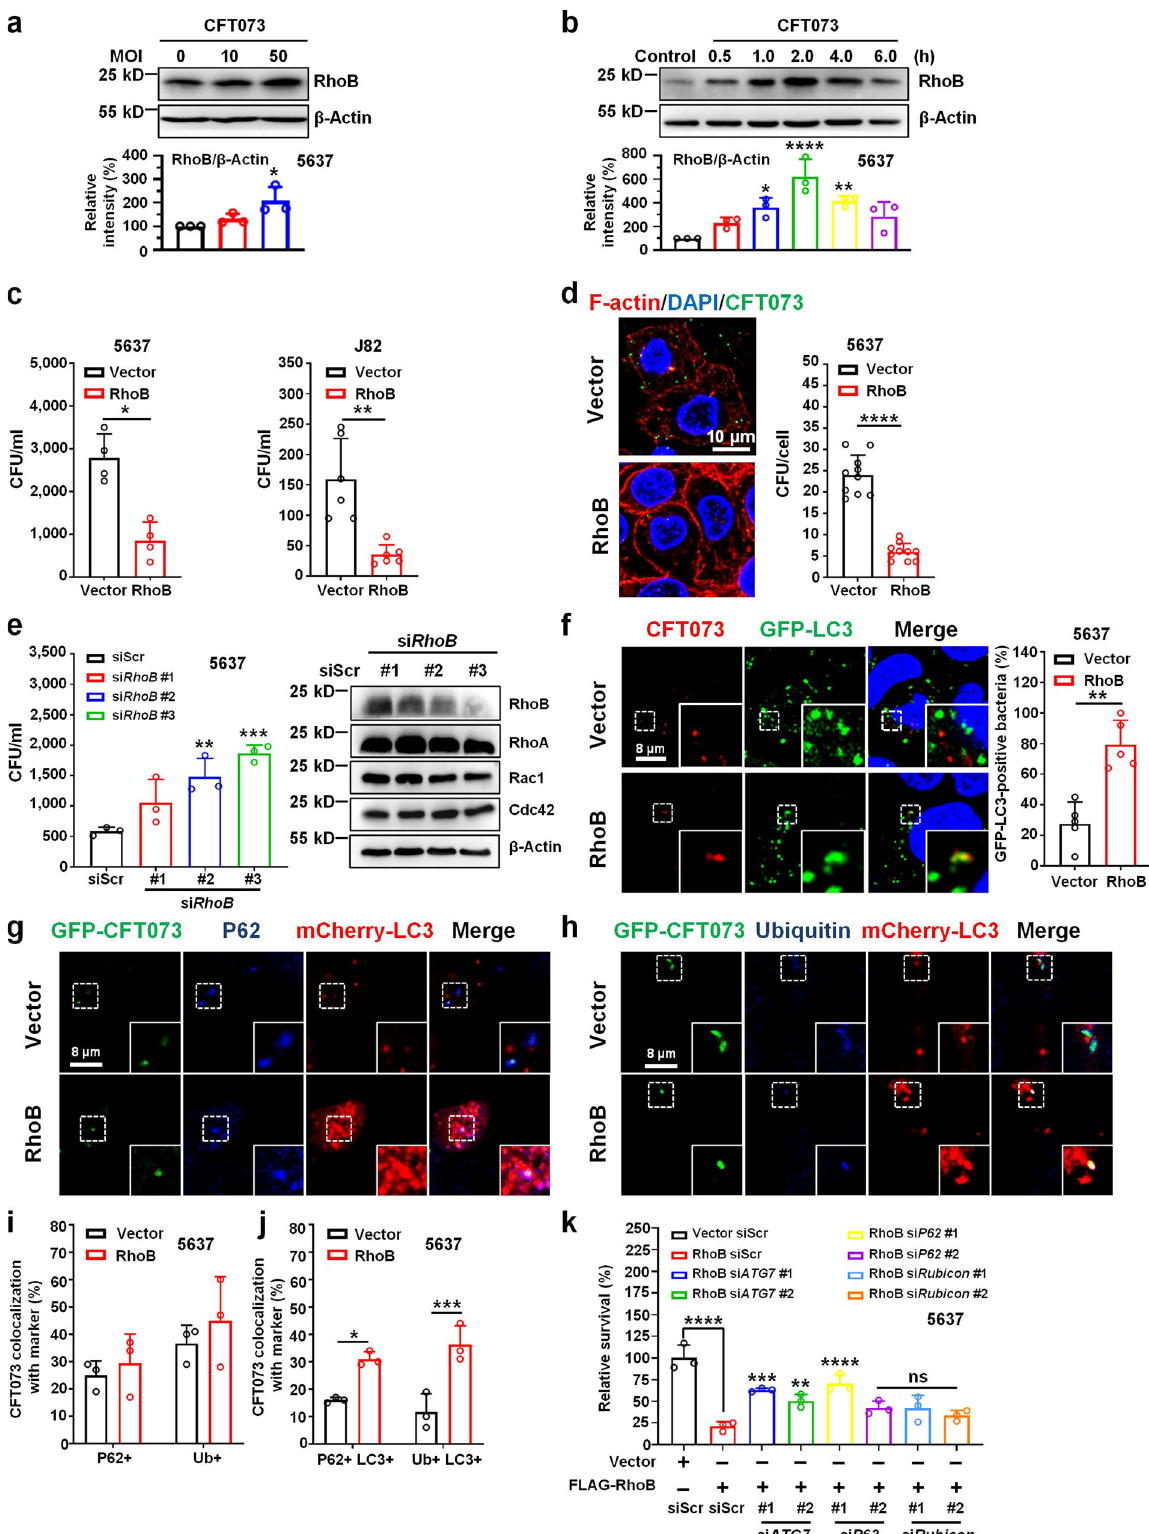
BafA1 also led to an increase of LC3-II in RhoB -overexpressing cells (Supplementary Fig. 3b), re fl ecting that RhoB likely pro- motes autophagic fl ux rather than blocking lysosomal degrada- tion. Notably, the decrease of Beclin 1, the core adaptor of PI3K complex that mediates autophagosome initiation, was observed when RhoB was knocked down (Fig. 2d). This reduction was